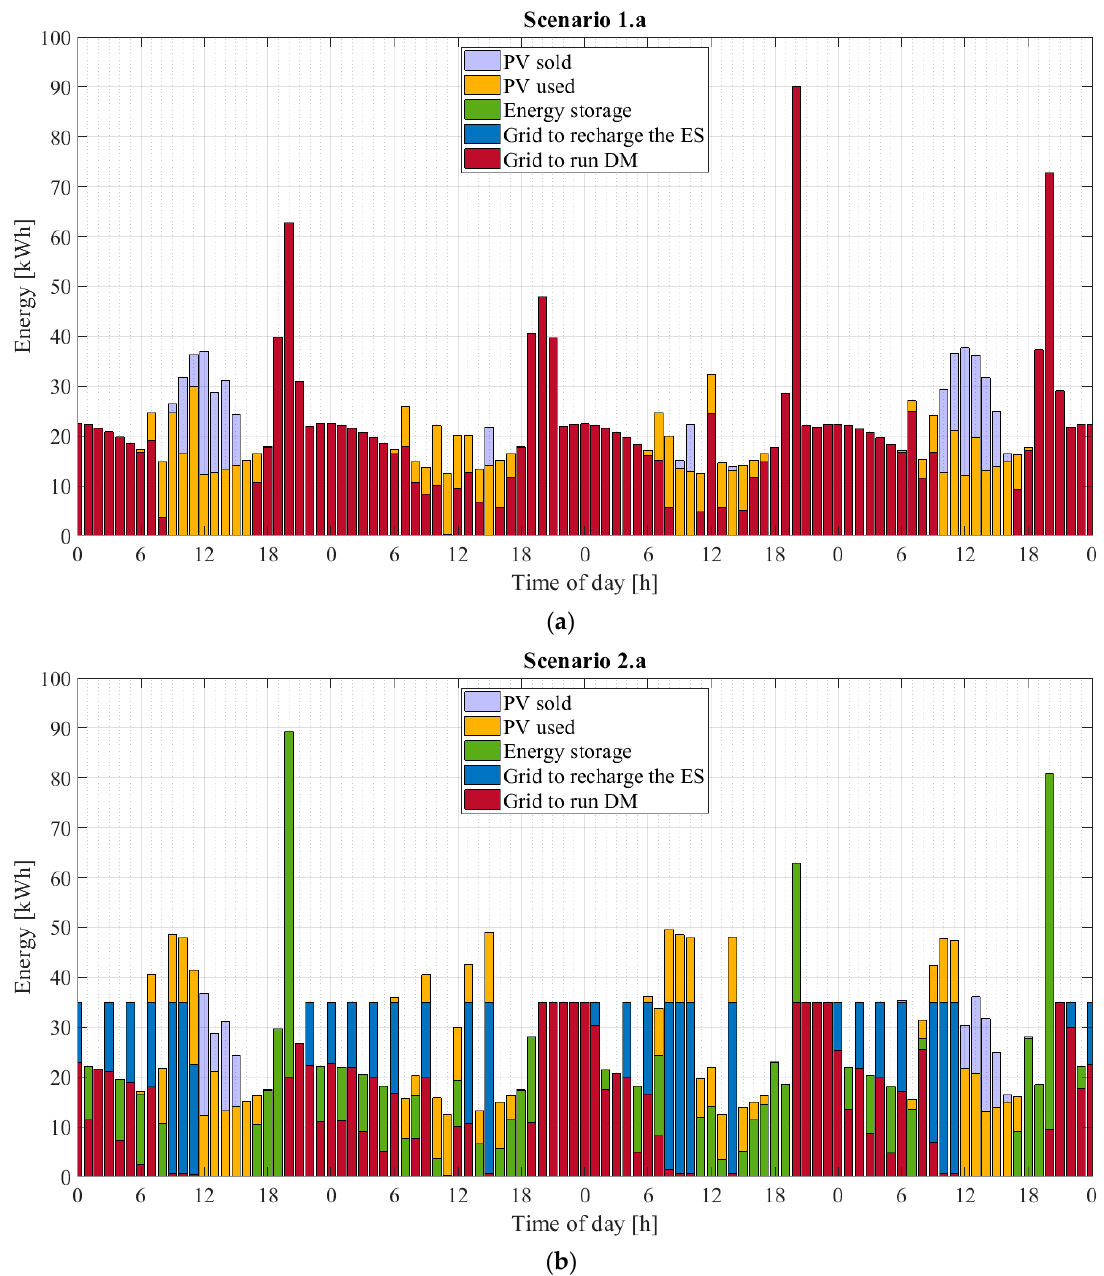
Figure 17. ( a ) Scenario 1.a and ( b ) Scenario 2.a with hourly resolution showing the energy profiles relative to 4 days at the end of